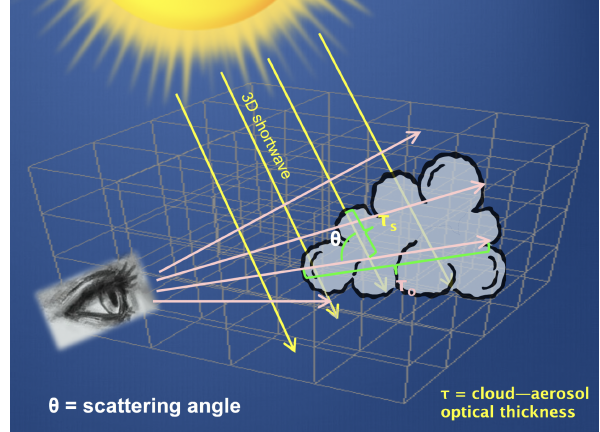
Figure 1. General ray tracing procedure showing forward light rays (yellow) coming from the light source. A second set of light rays (pink) is traced backward from the observer. The forward and back- ward optical thicknesses ( τ s and τ o ) are calculated along these lines of sight and used for subsequent calculations to estimate the radi- ance on an angular grid as seen by the